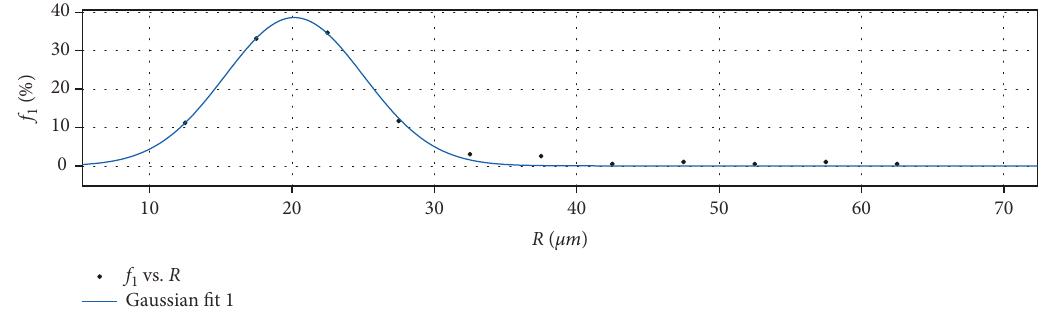
Figure 9: Data fi tting result of pore size distribution of the carbonized layer ’ s microsphere.